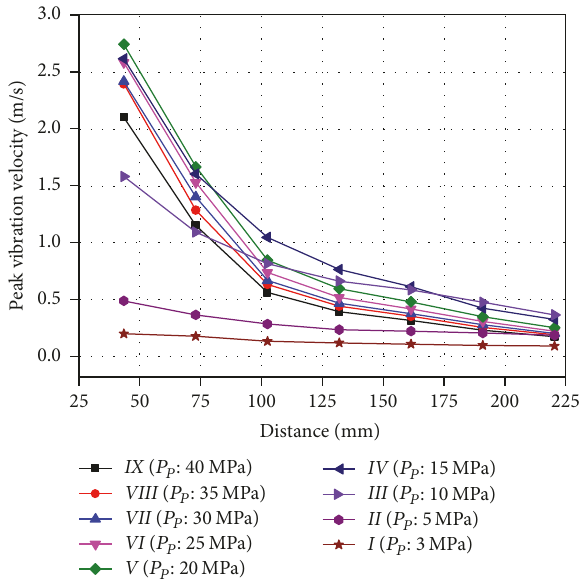
Figure 10: The vibration velocity attenuation curves under a single- impact from the PFC fracturing models at variable distances from the center of the borehole for each of the nine used peak